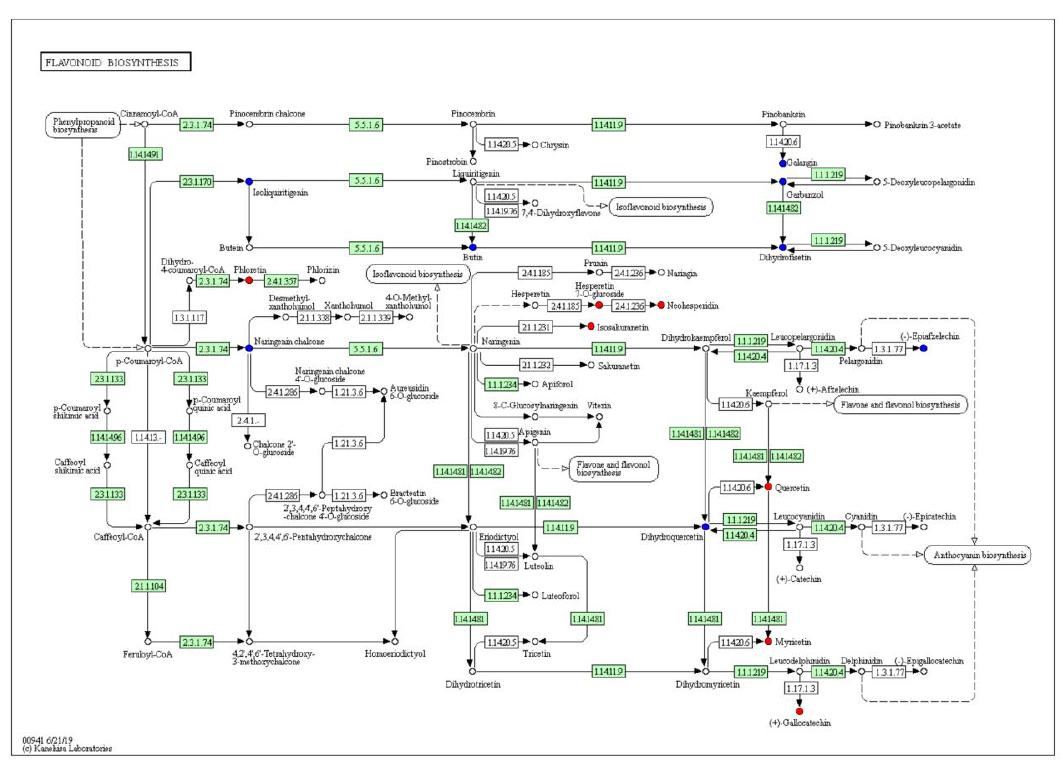
Figure 9. Flavonoid biosynthesis (https://www.kegg.jp/entry/map00941 (accessed on 10 January 2022)). Blue and red round dots represent down-regulated metabolite and up-regulated metabolite, respectively.